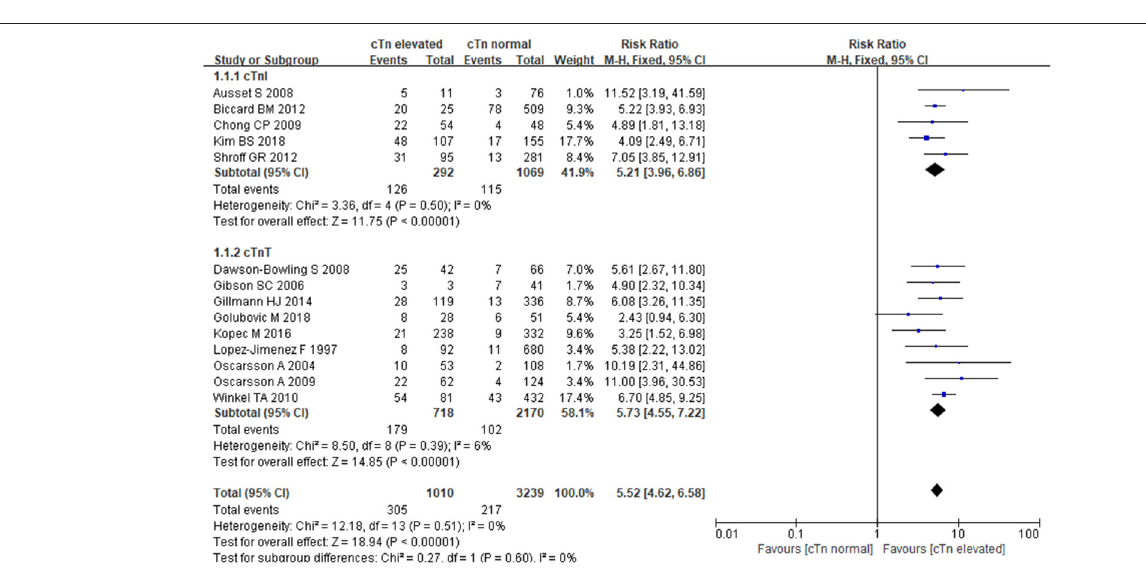
FIGURE 3 | The association between cTnI/cTnT and MACE.